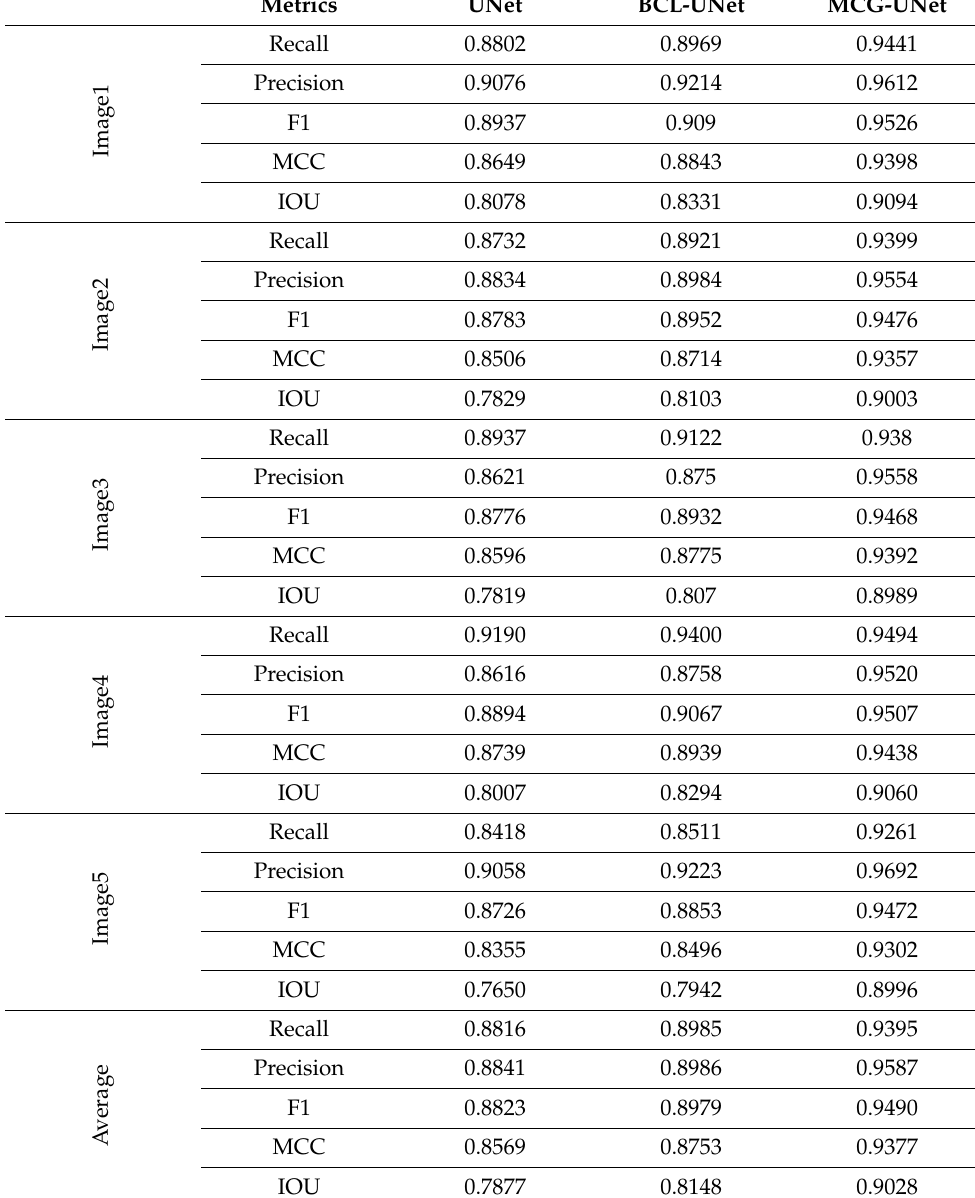
Table 3. Comparison of the MCG-UNet, BCL-UNet, and UNet networks for building